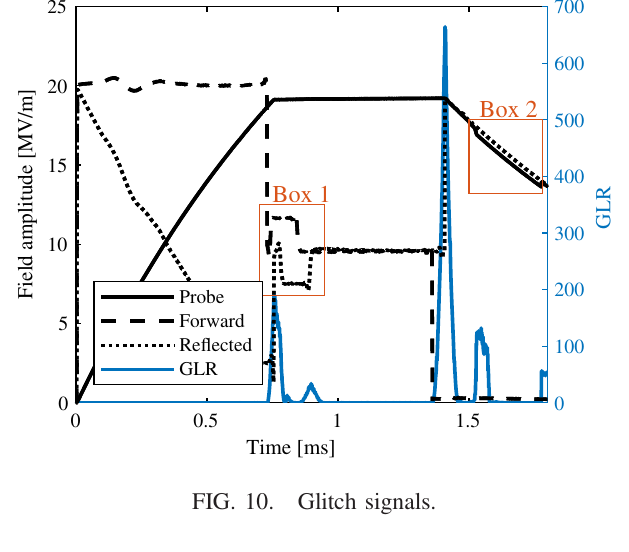
¯ λ 10 . 8 is marked GLR ¼